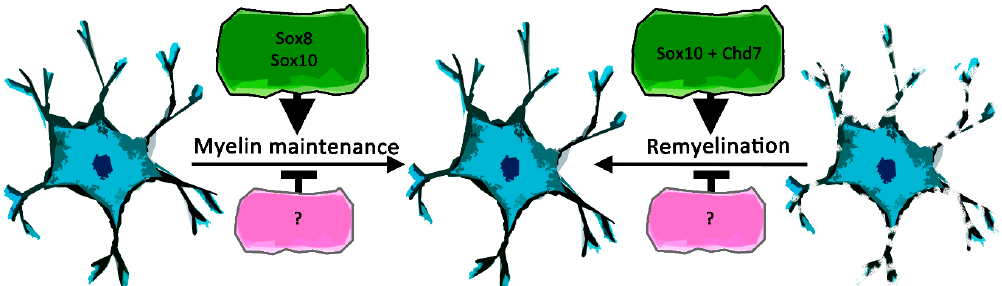
Figure 3. Schematic representation of recently described Sox protein functions in oligodendroglial myelin maintenance and remyelination. Positive effects are shown in green, negative effects in magenta, while proteins that directly interact with Sox proteins are annotated by “+”.